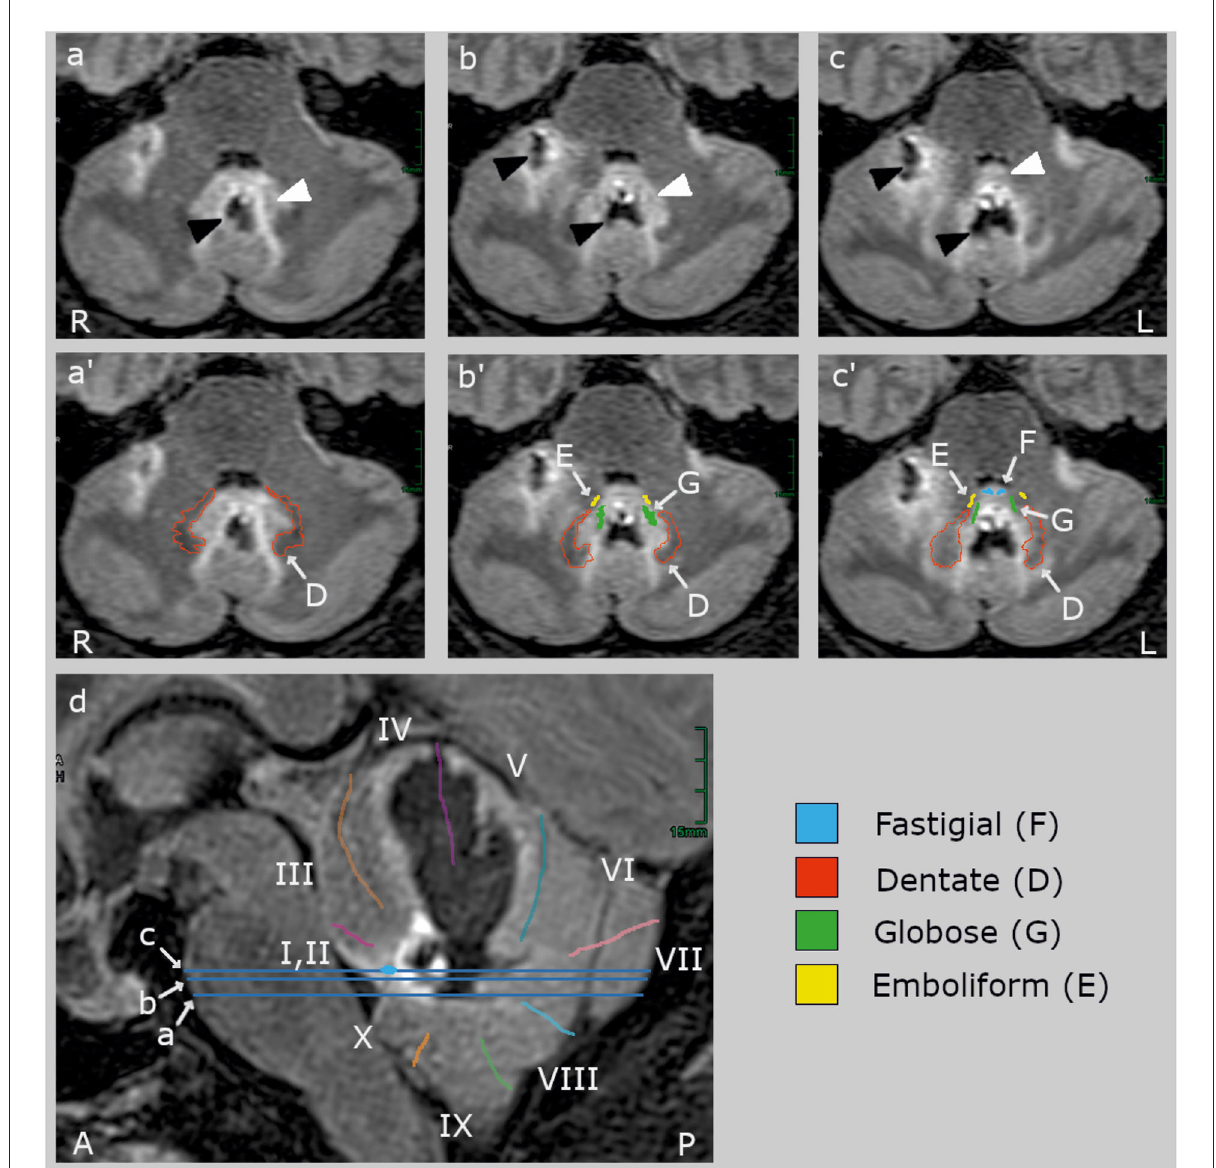
FIGURE1 Clinical high-resolution FLAIR images (Siemens Vida 3T MRI, Erlangen, Germany) with axial (a–c) and sagittal slices (d) . The blue lines on the sagittal slice indicate the location of the axial slices. The upper row (a–c) shows the lesion (black arrowheads) and its edema (white arrowheads) without cerebellar landmarks which are labeled in the middle (a’–c’) and lower row (d) . The hemorrhage (hypointense, black) centered in the midline between the deep cerebellar nuclei and extended rostrally into the vermal lobules IV and V and the right hemispheric lobules V and VI (40, 41). The edema (hyperintense, light gray) involved bilaterally the fastigial nucleus (F, blue) anteriorly to the hemorrhage at the roof of the fourth ventricle, most likely impairing inter-fastigial projections (15), and laterally the interpositus composed of the globose (G) and emboliform (E) nuclei, and the medial part of the dentate nucleus (D). The lesion did not comprise (oculomotor) hemispheric lobule VI (simple lobule), the posterior oculomotor vermal lobules VI and VI (OMV), flocculus, paraflocculus, and caudal vermal uvula and nodulus. There was no brainstem lesion.